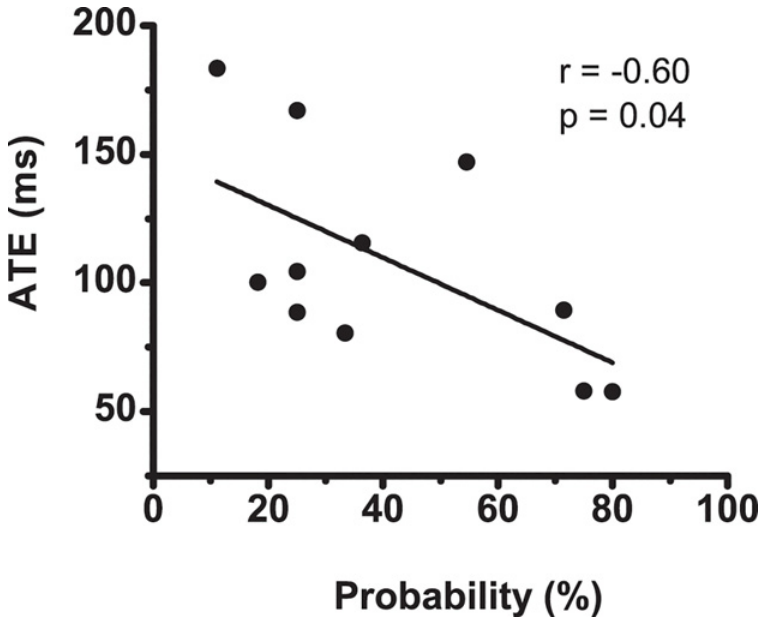
Fig 3. Relationship between ATE and probability. Relationship between absolute temporal error (ATE) in response to decreased velocity condition and probability that biphasic EMG pattern will appear in response to this